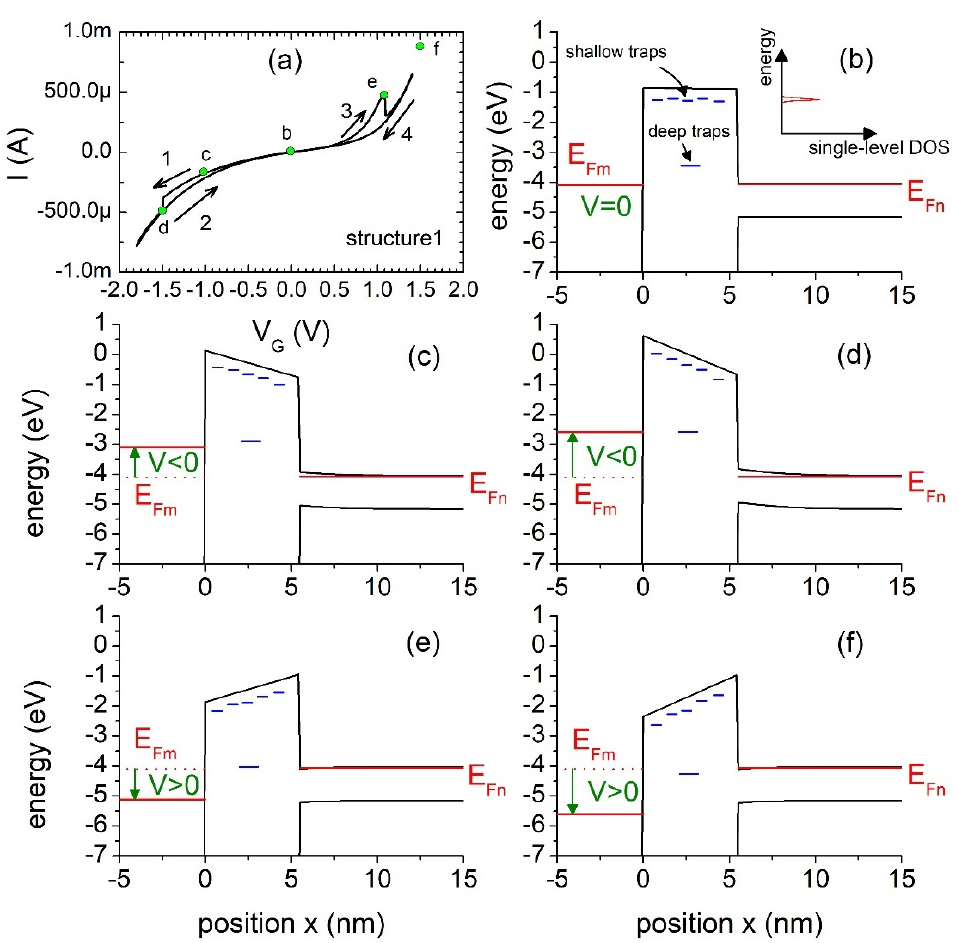
Figure 5. Energy band diagrams of the MIS structure no. 1 with marked trap energy levels in the dielectric for V = 0 ( b ), V < 0 ( c , d ) and V > 0 ( e , f ). Shallow trap levels are shown schematically, whereas the deep trap energy level position is calculated. Points corresponding to the band diagrams were marked in ( a